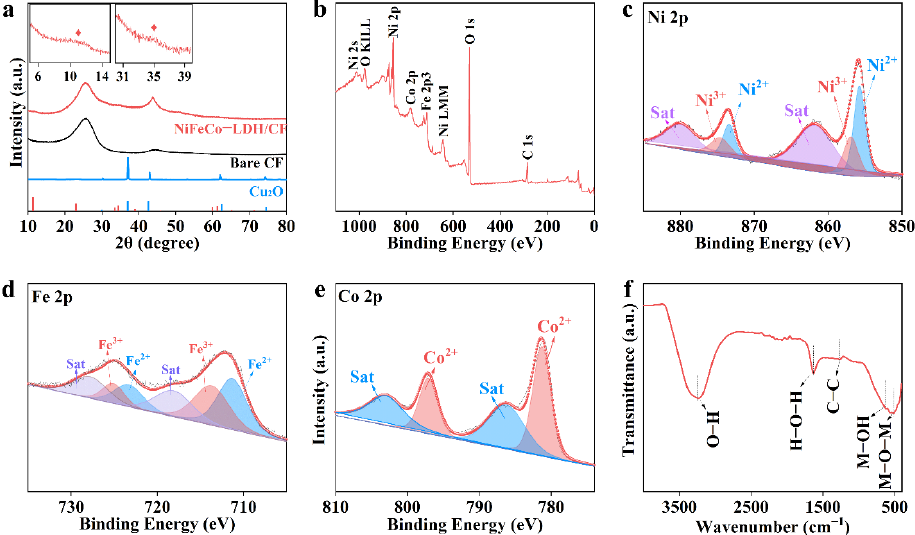
Figure 3. ( a ) XRD spectra of Cu 2 O and NiFeCo ‐ LDH/CF. XPS spectra of NiFeCo ‐ LDH/CF ( b ) survey, ( c ) Ni 2p, ( d ) Fe 2p, and ( e ) Co 2p. ( f ) FT ‐ IR spectra of NiFeCo ‐ LDH/CF.